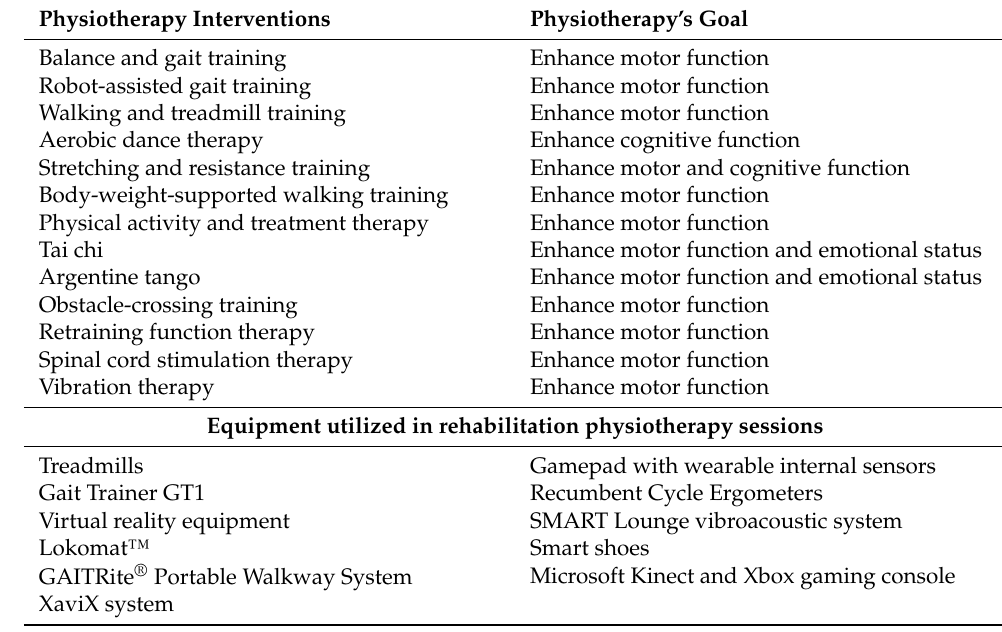
Table 2. Physiotherapy interventions in Parkinson’s disease and equipment utilized through clini- cal